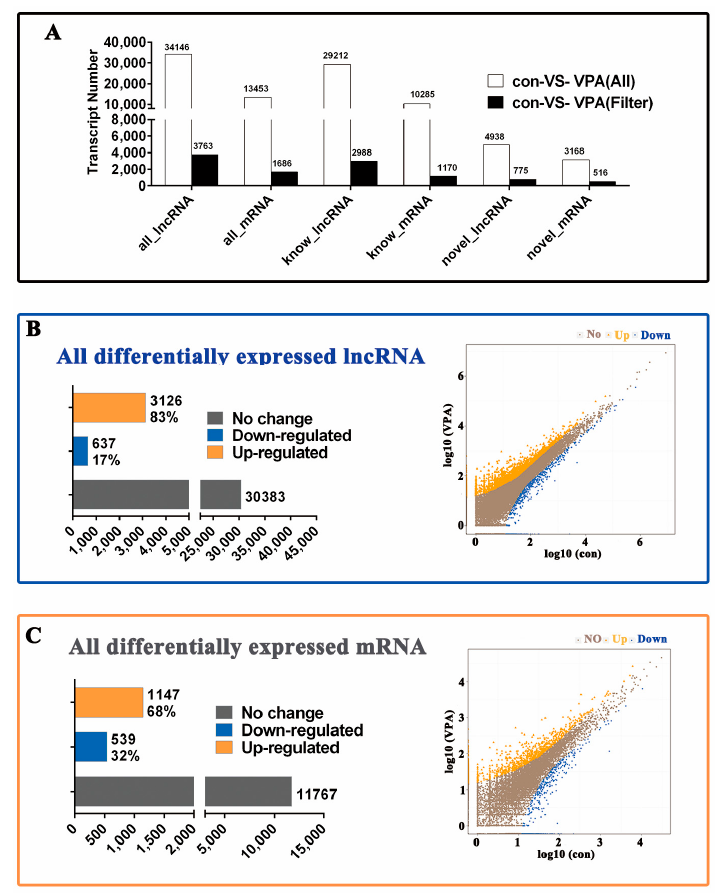
Figure 4. Profiling of the differentially expressed (DE) lncRNAs and mRNAs in the hHSC myofibroblasts between the activated hHSCs (con) and quiescent hHSCs (VPA). ( A ) Histograms represent the significant and nonsignificant differences in transcripts between the con (activated hHSC) and VPA (quiescent hHSC), con-VS-VPA (All) is the significant differences, whereas the con-VS-VPA (Filter) represents the significant differences only. ( B , C ) Histograms and Scatter plot of the co-expressed transcripts between con and VPA. ( B , C ) represent the lncRNAs and mRNAs, respectively. Blue denotes downregulated RNA transcripts, orange denotes the upregulated RNA transcripts, and brown denotes the nonregulated RNA transcripts in VPA (quiescent hHSC) compared with con (activated hHSC).